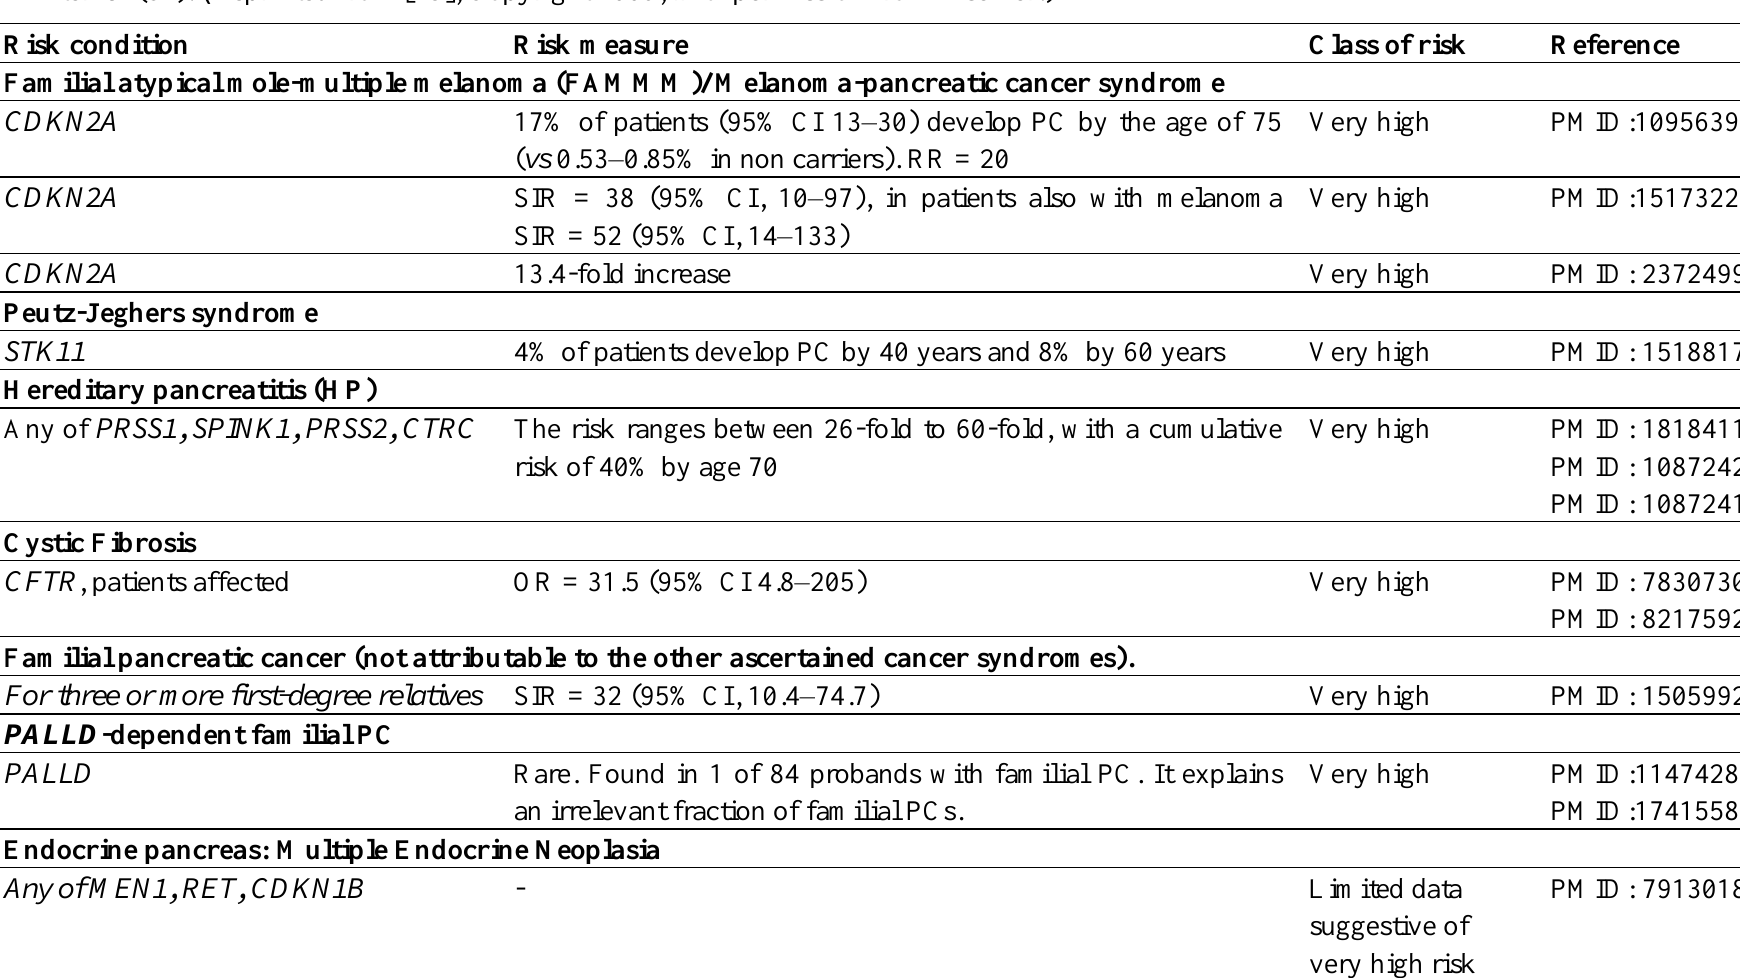
Table 1. Risk factors for PC according to known diseases, familial factors, or environmental exposures. Classes of risk are categorized, arbitrarily, as reported in Section 5. Abbreviations used: Standardized Incidence Rate (SIR), Odd Ratio (OR), Relative Risk (RR), Confidence Interval (CI). ( Reprinted from [28], Copyright 2009, with permission from